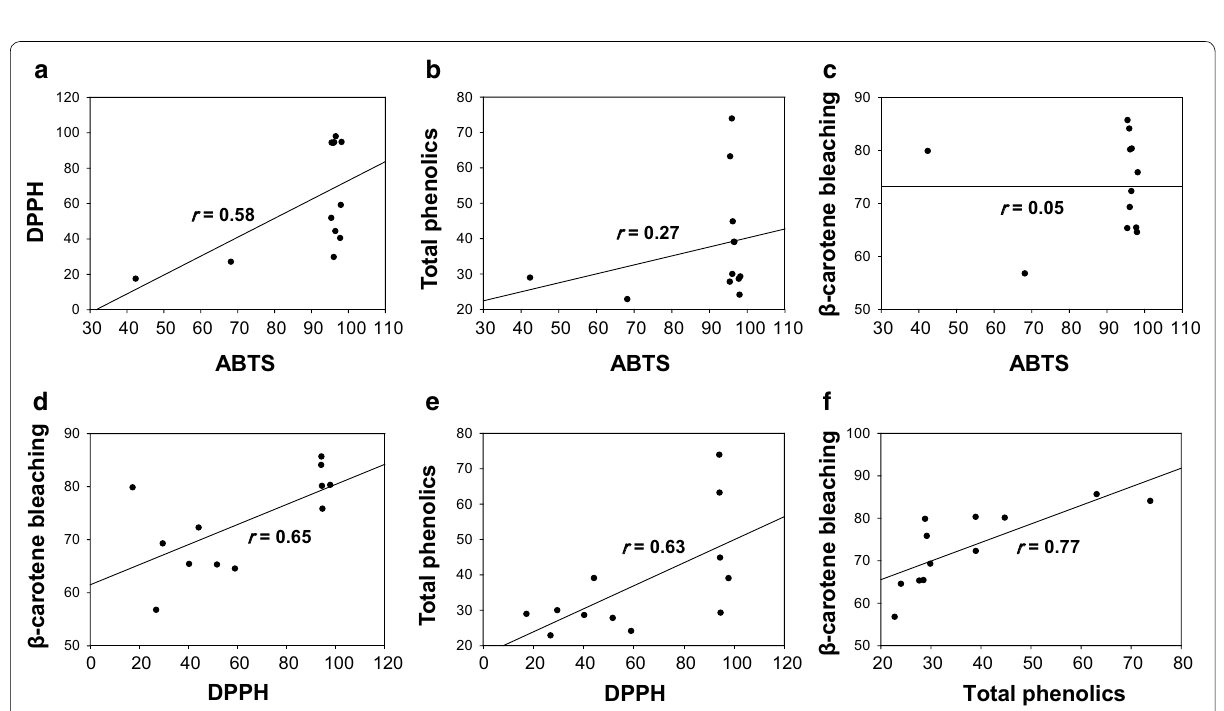
Fig. 4 Scatterplot of the interaction between the different methods to measure antioxidant activity. The correlation was determined by the Spearman coefficient of correlation method. Correlation coefficient between ABTS and either a DPPH ( r ( r 0.27, p > 0.05). Correlation coefficient between β‑carotene bleaching and either c ABTS ( r = Correlation coefficient between total phenolics and either e DPPH ( r